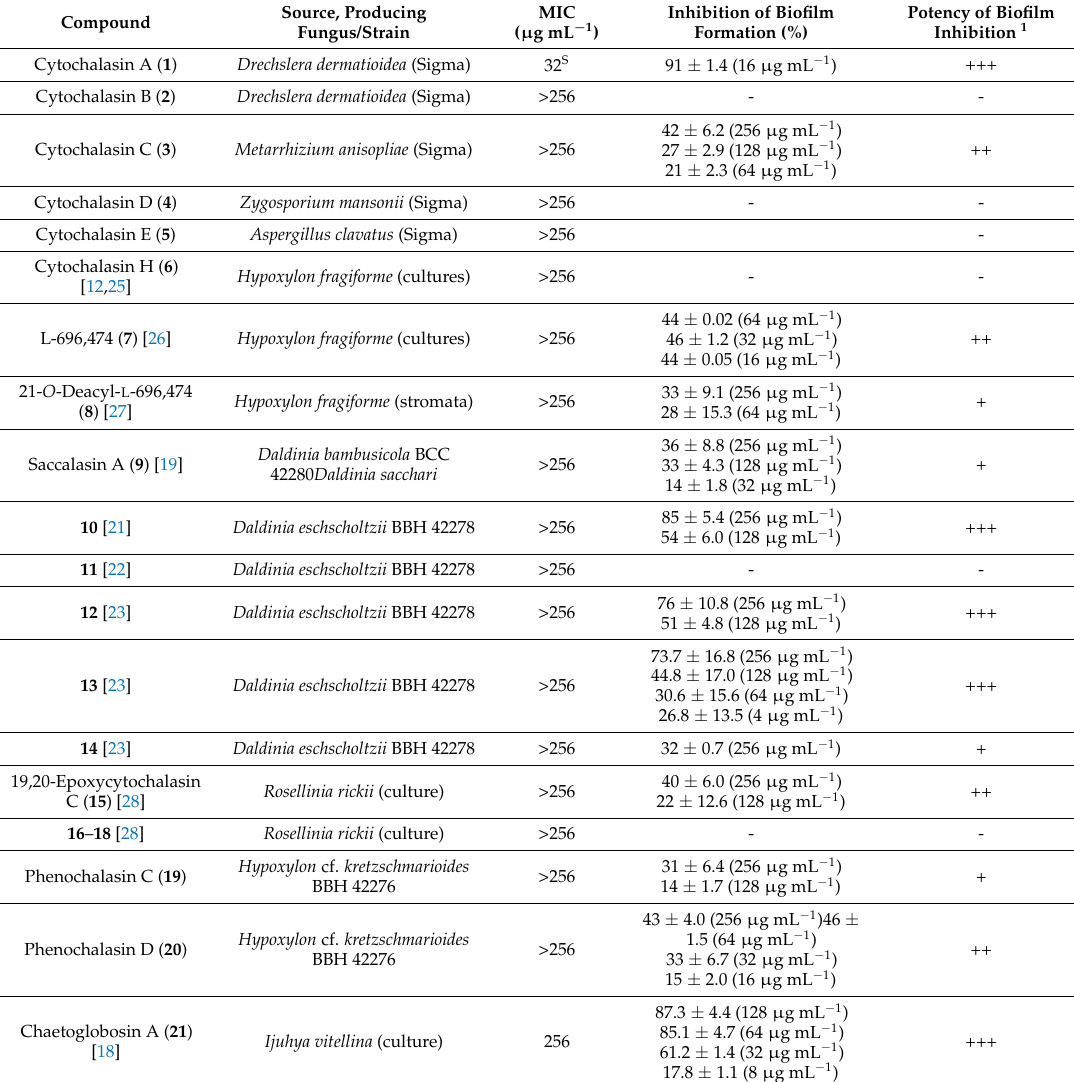
Table 2. Origin and anti-biofilm activities of the tested cytochalasans. BCC: BIOTEC culture collection, BBH: BIOTEC Bangkok